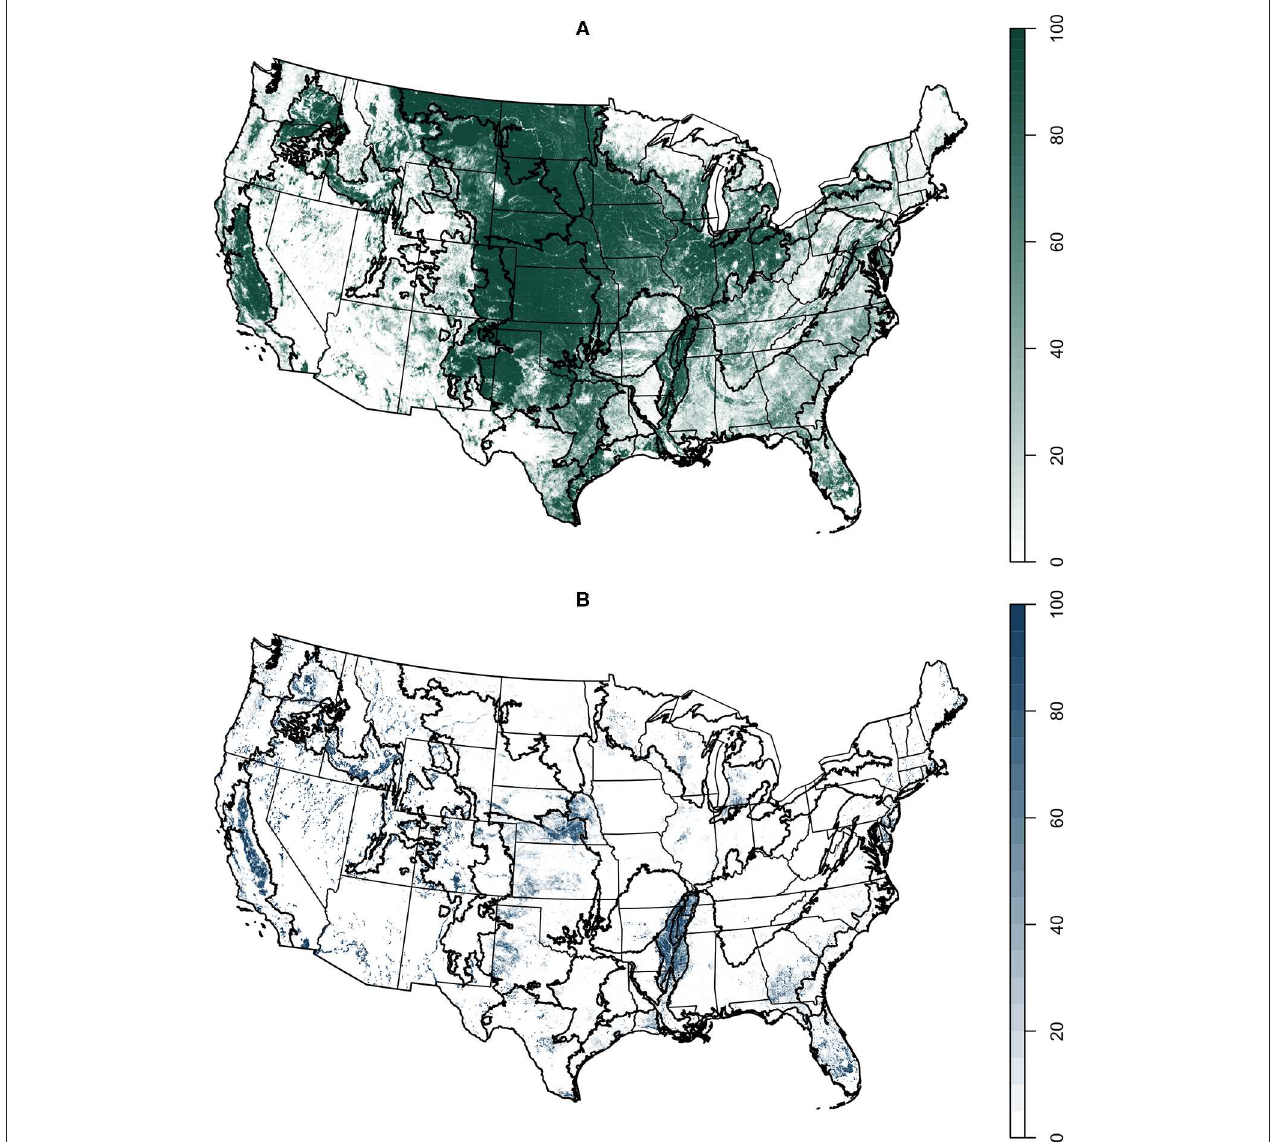
FIGURE 2 | (A) Maximum percentage of agricultural land, 2008–2018. (B) Irrigated agricultural area, 2012.